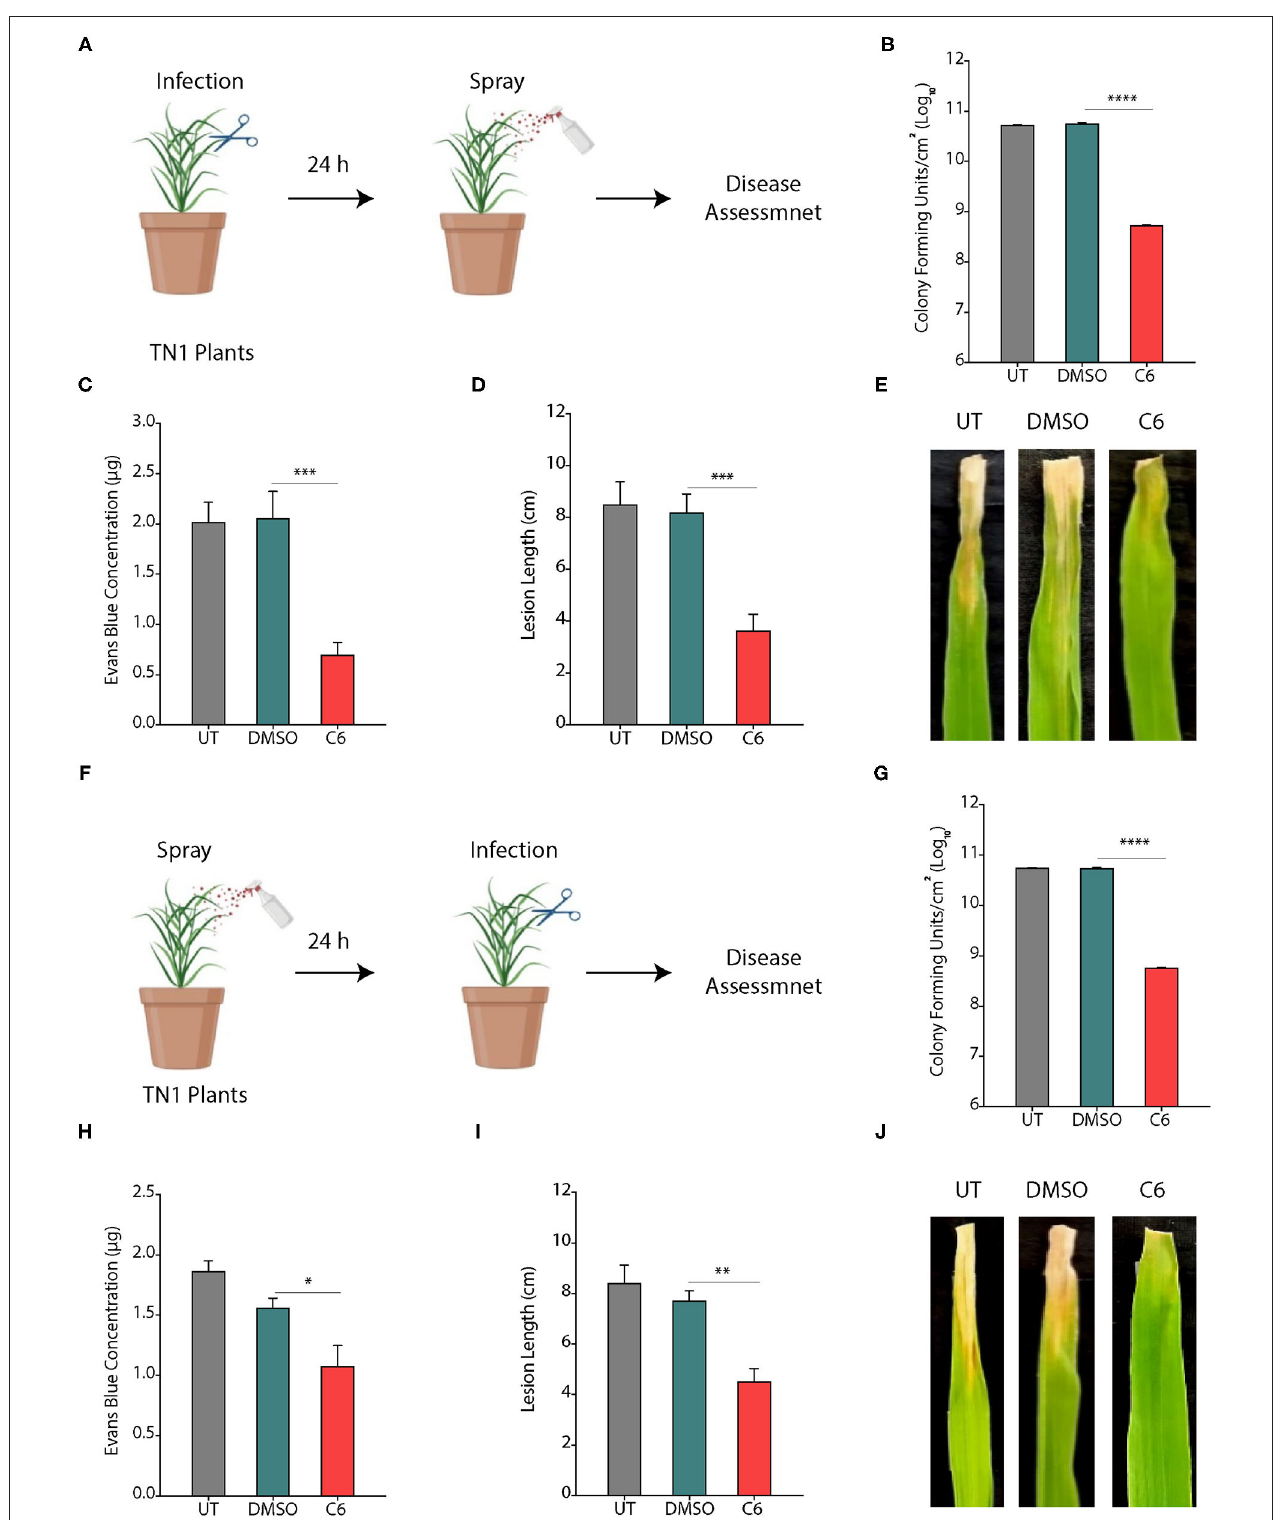
FIGURE 4 | CAGCs protect plants from Xoo infections. (A) Scheme showing outline of the study where pre-infection with Xoo was followed by treatment with C6 CAGC. (B) Change in CFUs of Xoo on treatment with C6 ( α = 0.05, **** p < 0.0001). (C) Membrane stability assessment by Evan’s blue dye quantification in untreated and C6-treated Xoo -infected rice leaves ( α = 0.05, *** p < 0.001). (D) Change in pathogen induced lesion length in untreated and C6-treated Xoo -infected rice leaves ( α = 0.05, *** p < 0.001). (E) The photographs showing bacterial leaf blight symptoms on TN1 rice leaves treated with C6. The images were taken after 10 days of Xoo